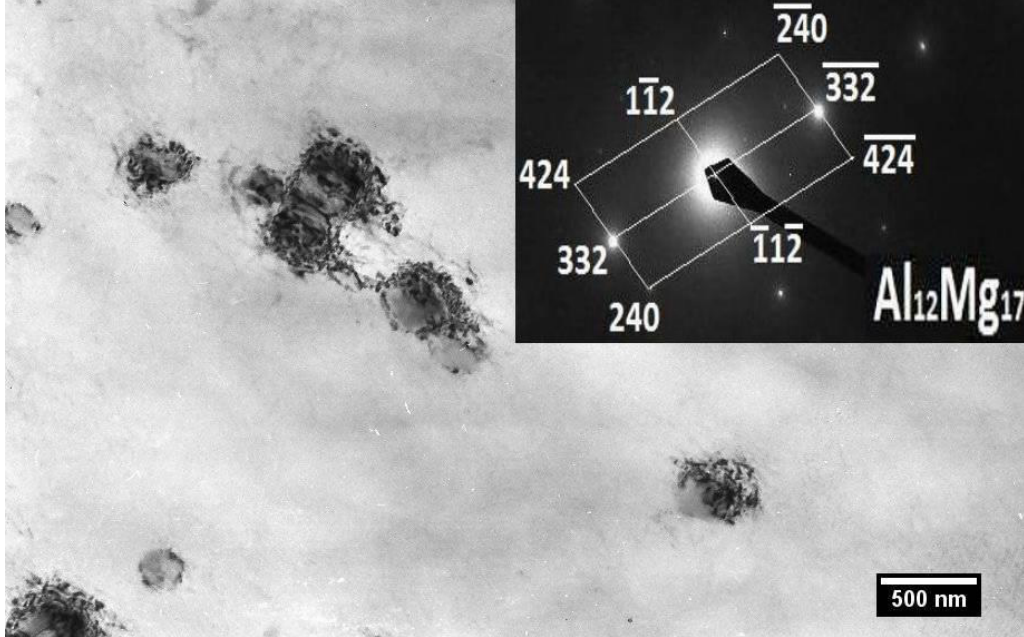
Figure 9. TEM image detailing the small precipitates inside the grain and the electron diffraction pattern of the particles.